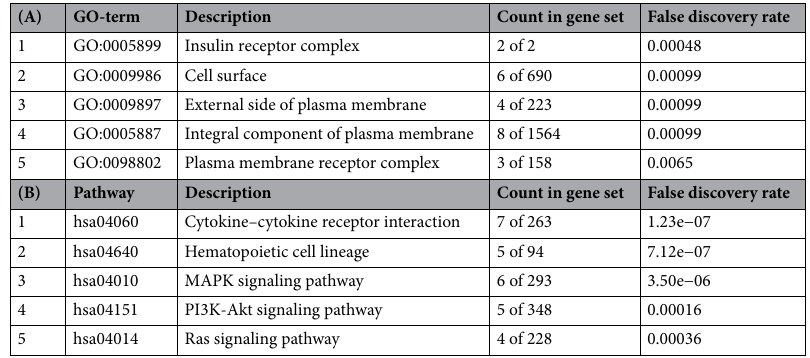
Table 2. KEGG pathway and Cellular processes analysis of Hub genes implicated in EOCRC progression on STRING database. (A) Cellular process analysis of Hub genes on string database. (B) KEGG pathway analysis of Hub genes on string database.